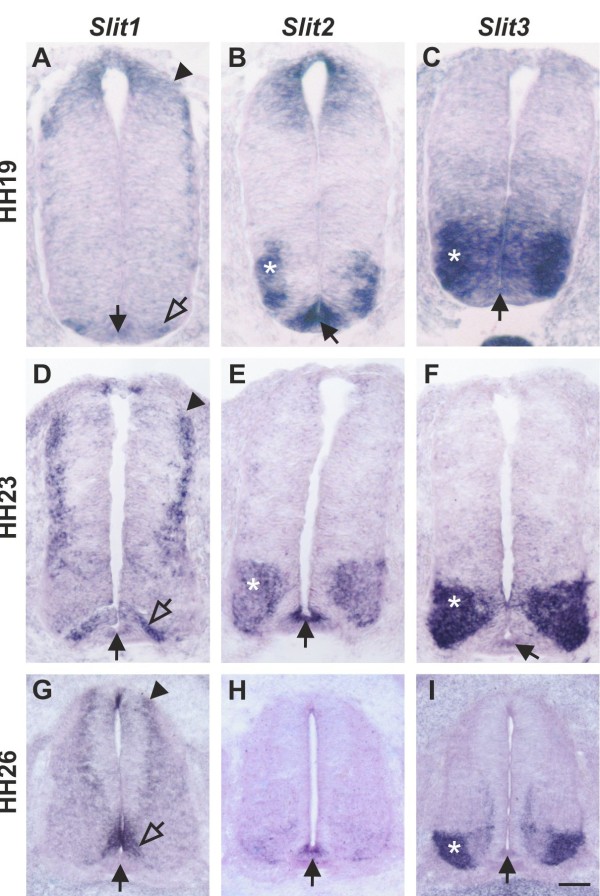
Slits are expressed in the floor-plate area of the embryonic chicken spinal cord. In agreement with published reports [29,68], Slit1 was expressed weakly in the floor plate at HH19, when commissural axons start to extend in the dorsal spinal cord but before they reach the floor plate (black arrow in A). Interestingly, Slit1 was also expressed in commissural neurons throughout axonal pathfinding (HH19-26; arrowheads in ADG). Slit1 was expressed more strongly in cells flanking the floor plate (open arrows in ADG) rather than the floor plate itself (arrow; DG). By HH26, Slit1 was no longer expressed in the floor plate (arrow in G) but persisted in cells flanking the floor plate. Slit2 was strongly expressed in the floor plate (arrow in BEH), in agreement with published findings [29,68]. Furthermore, Slit2 was expressed by motoneurons (asterisks in BE). Slit3 was strongly expressed in motoneurons (asterisks in CFI), but only at low levels, if at all, in the floor plate (arrows in CFI). Thus Slit expression shows some differences between chicken and rodent embryos [25,33]. In mouse [33] and in rat [25], Slit1 is expressed in the floor plate rather than in cells flanking the floor plate. Mouse but not rat motoneurons express Slit3 between E10.5 to E13.5. Motoneurons are the predominant site of Slit3 expression in the chick at HH23. Overall, Slit expression is conserved between chicken embryos and rodents, although the patterns of individual Slits differ significantly. Bar: 33 μm in AC, 50 μm in DF, 100 μm in GI.